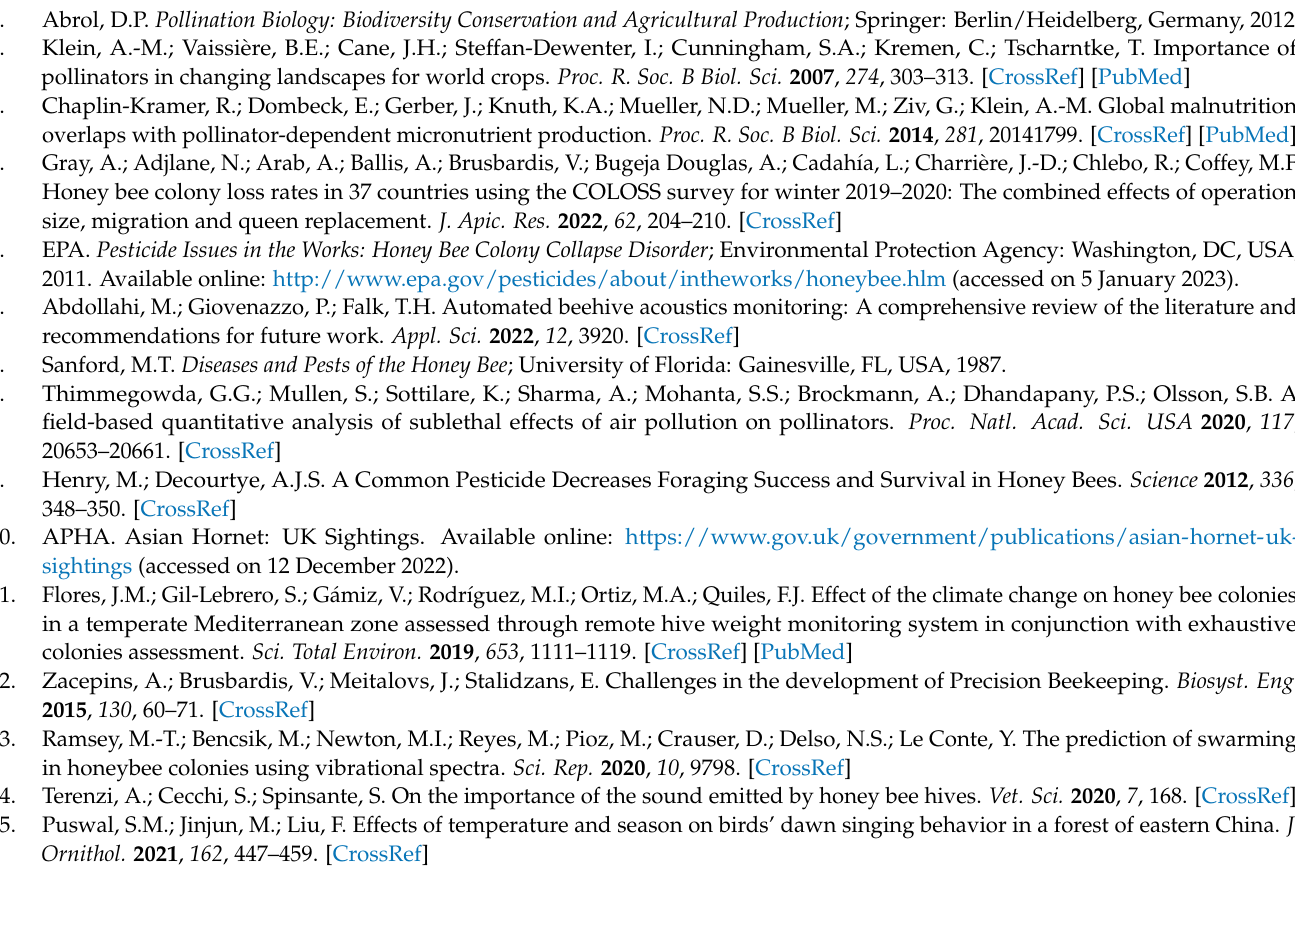
Figure S3: Level of education of the experts who provided their feedback via a questionnaire; Figure S4: Employment status of the experts who participated in responding to the